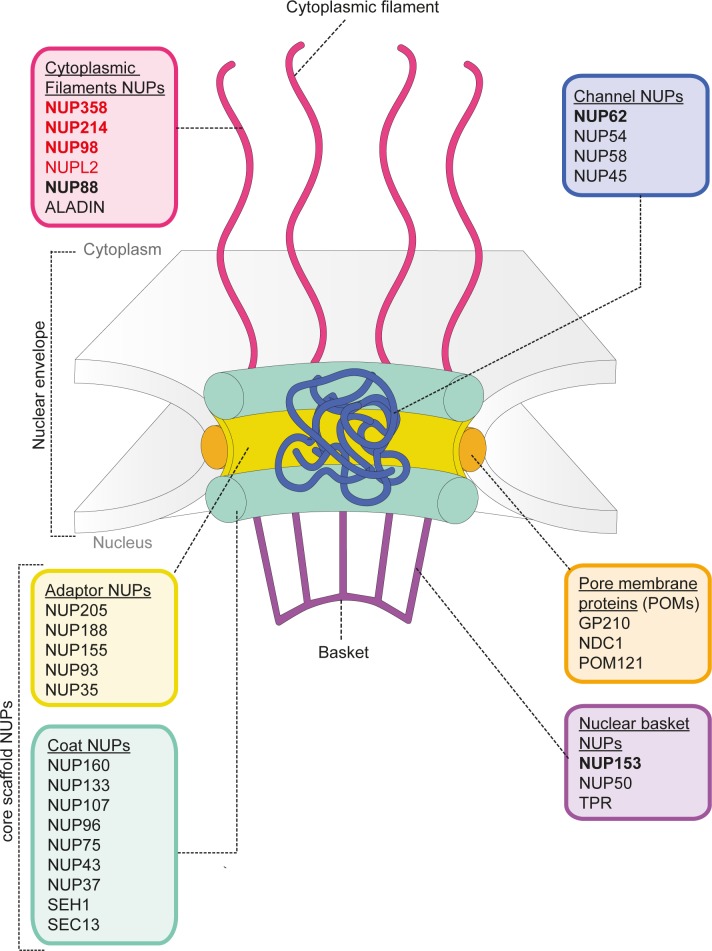
Nucleoporins interacting with MX2 are located at the cytoplasmic face of the nuclear pore.Schematic diagram indicating the structure and organization of the nuclear pore complex as described in Hoelz et al [22]. Nucleoporins interacting with MX2 (identified by Y-2-H screening) are shown in red. Nucleoporins required for MX2 activity (defined as those for which specific depletion elicited >50% reduction in MX2 dependent inhibition of HIV-1, in either HeLa or U87-MG cells) are shown in bold. Nucleoporins that interact with MX2 and are required for MX2 inhibition are shown in red and bold.